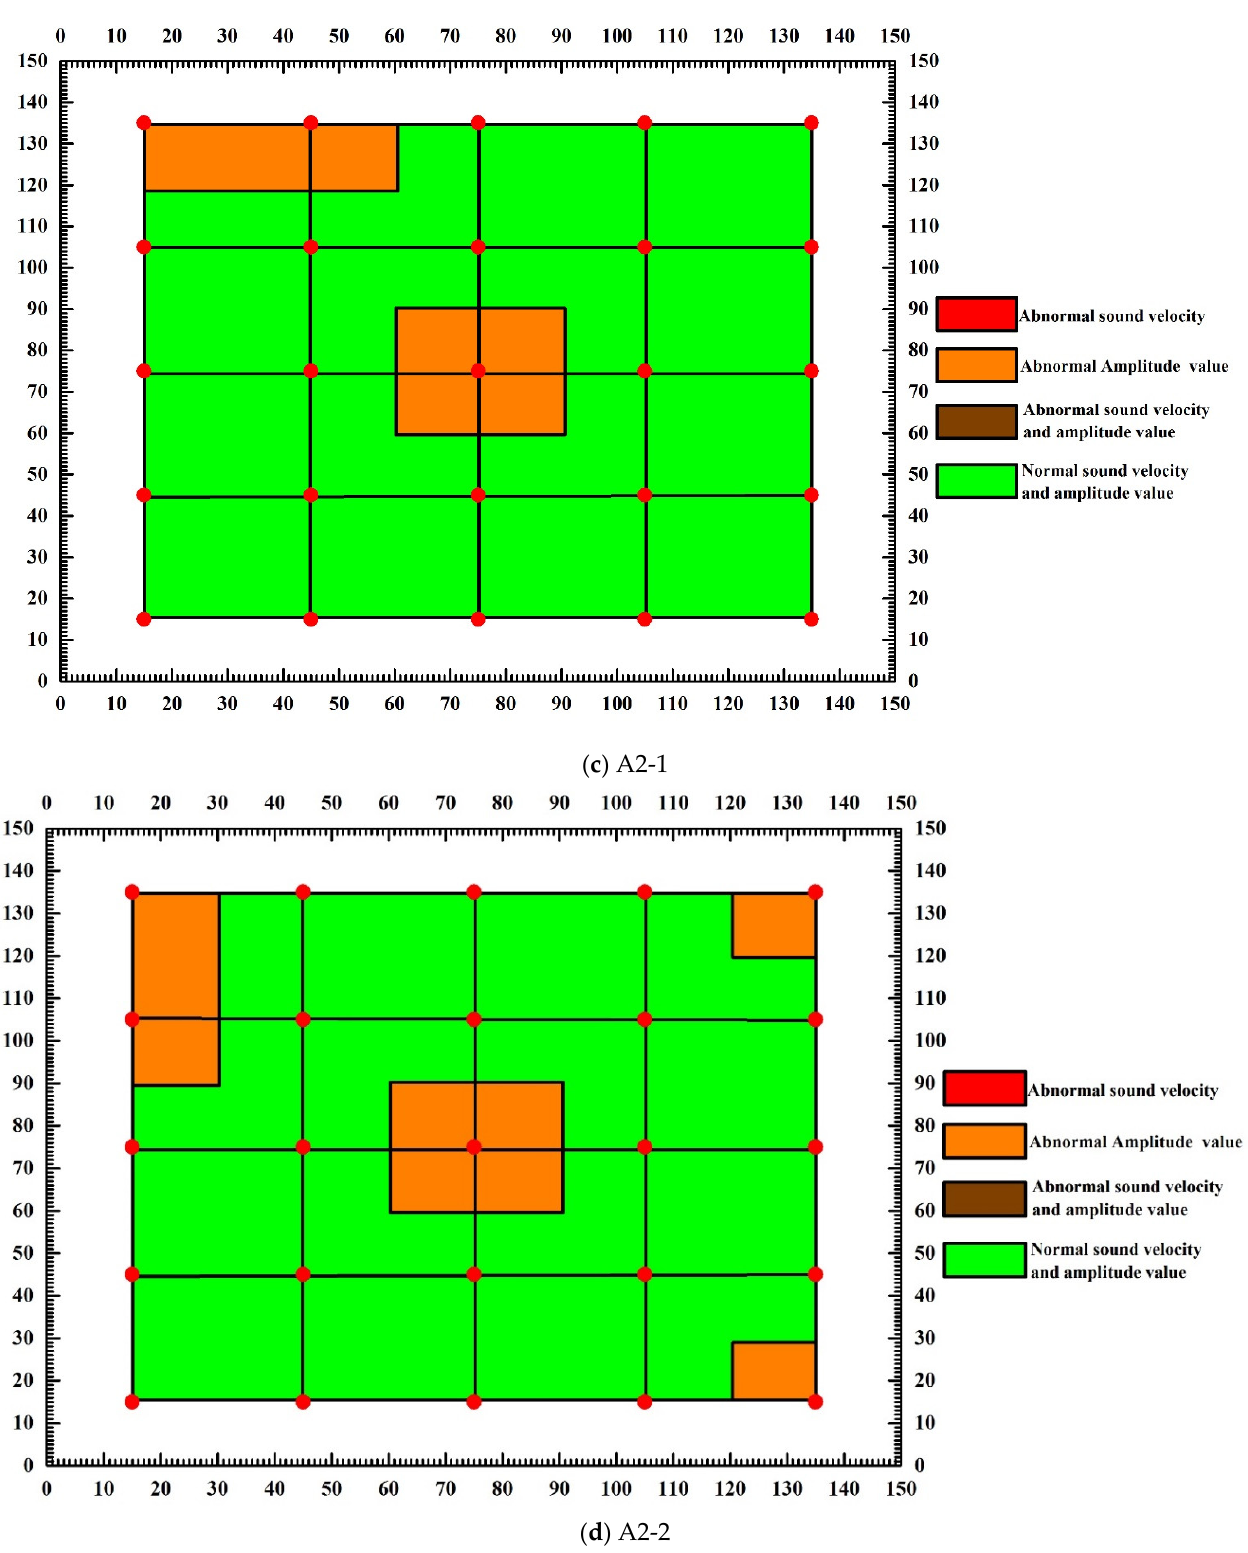
Figure 15. Defect distribution after the failure of each test block.